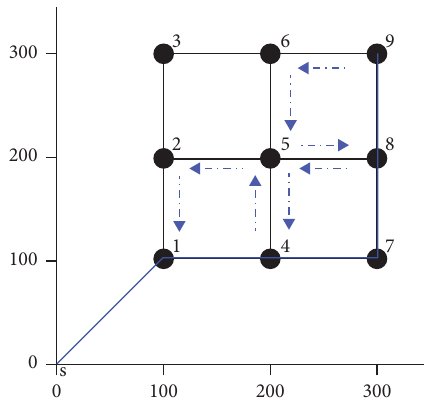
Figure 3: Blue line for a TFS operating a grid network and allowed detours and stop skipping.